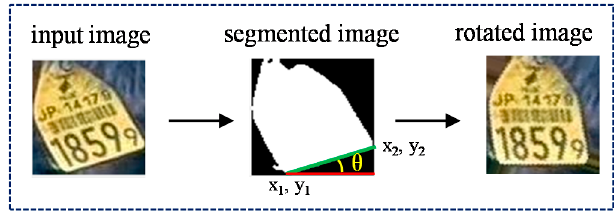
Figure 8. Illustration of skew image correction.